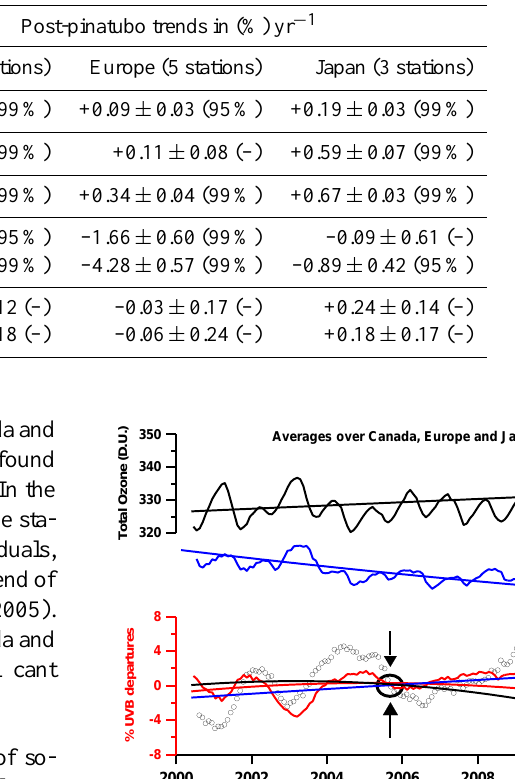
Table 3. Trends (in % per year) over Canada, Europe and Japan. Values in brackets refer to statistical significance of each trend.